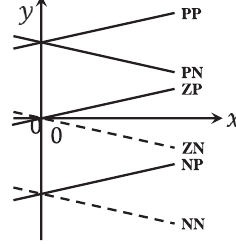
FIG. 1. Graphical representation of the six possible answer options. Full lines are the function types under study, dashed lines are buffer distractors. Abbreviations denote the sign ( N for negative, Z for zero, and P for positive) of the y intercept and the slope,